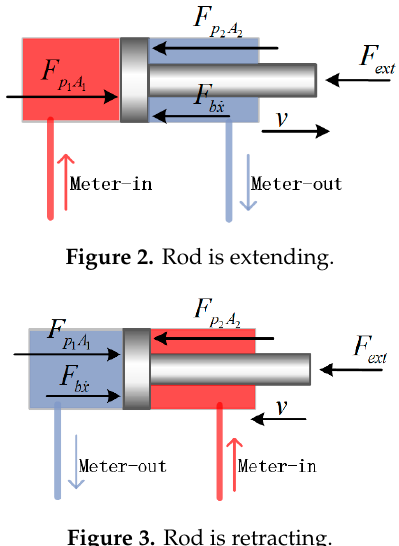
Figure 3. Rod is Figure 3. Rod is retracting. Figure 3. Rod is retracting.